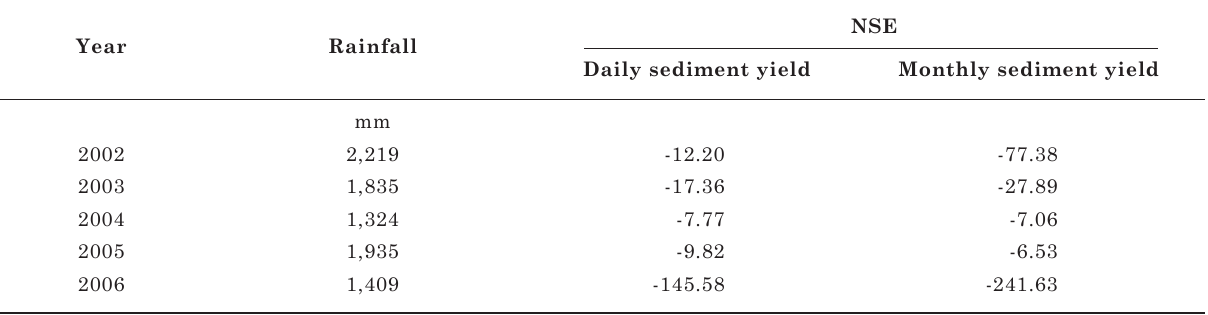
table 3. nse results for daily sediment yield from 2002 to 2006